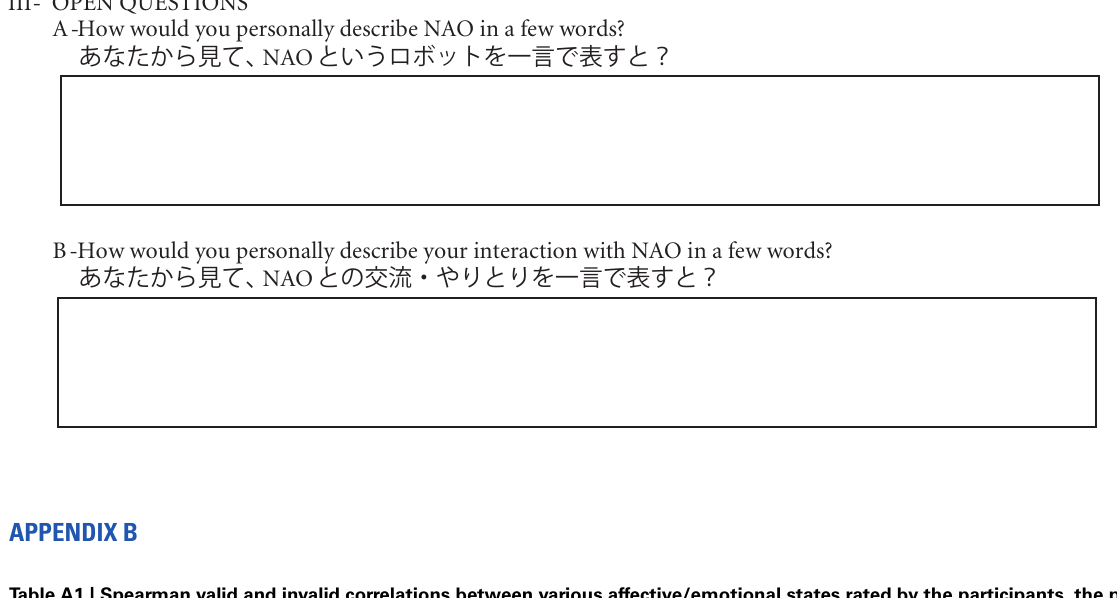
Table A1 | Spearman valid and invalid correlations between various affective/emotional states rated by the participants, the participants’ evaluation of NAO as possibly hostile/aggressive, and various motion variables. Smo. Smo.